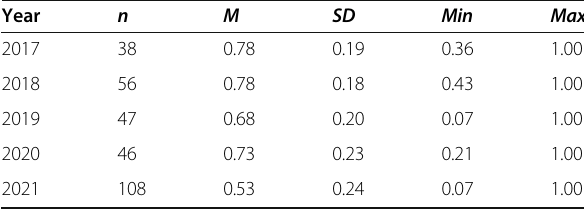
Table 8 Water Balance Model descriptive